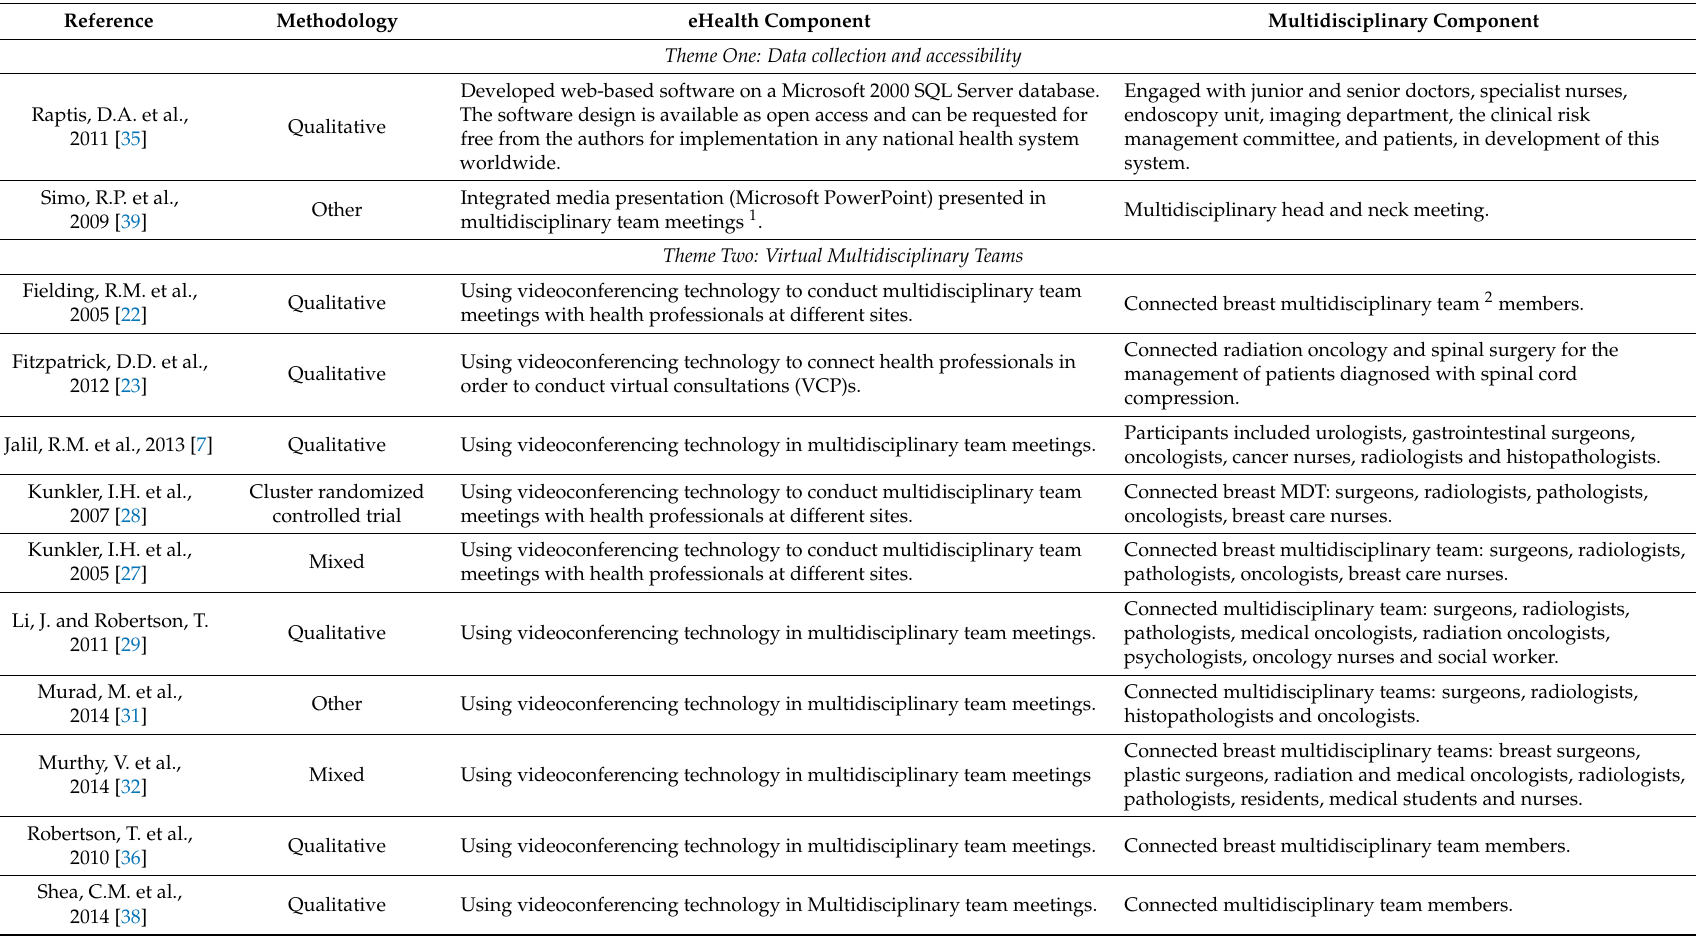
Table 2. Overview of the articles, themes, eHealth components, and interdisciplinary components of the included studies